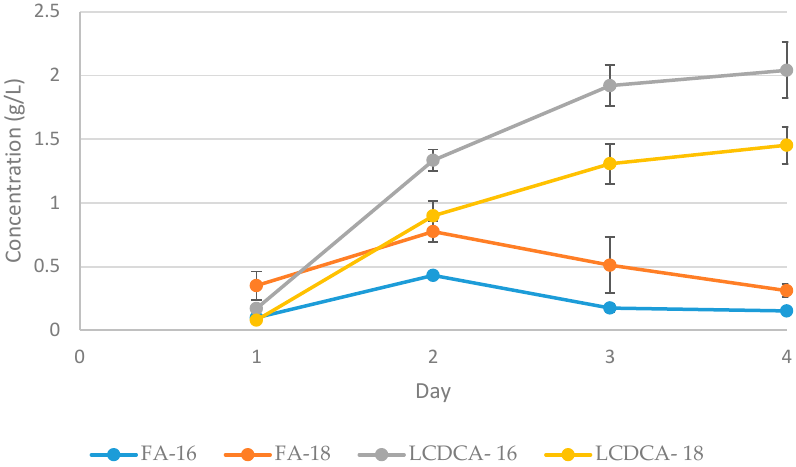
Figure 5. Time course study of fatty acids and LCDCA production by the ML strain/treatment. Glycerol based media under nitrogen-limiting conditions (C/N = 50). ML: ∆ POX1 -6 ∆ LEU2 ∆ SNF1 ∆ FAA1 ∆ LEU2:: YlALK5 YlCPR YlFAO1 + YlALK5:: URA3 + 400 mg/L leucine. FA-16: fatty acid of 16 carbons, FA-18: fatty acid of 18 carbons, LCDCA-16: long chain dicarboxylic acids of 16 carbons, LCDCA-18: long chain dicarboxylic acids of 18 carbons. Data from two rounds of batch fermentation.